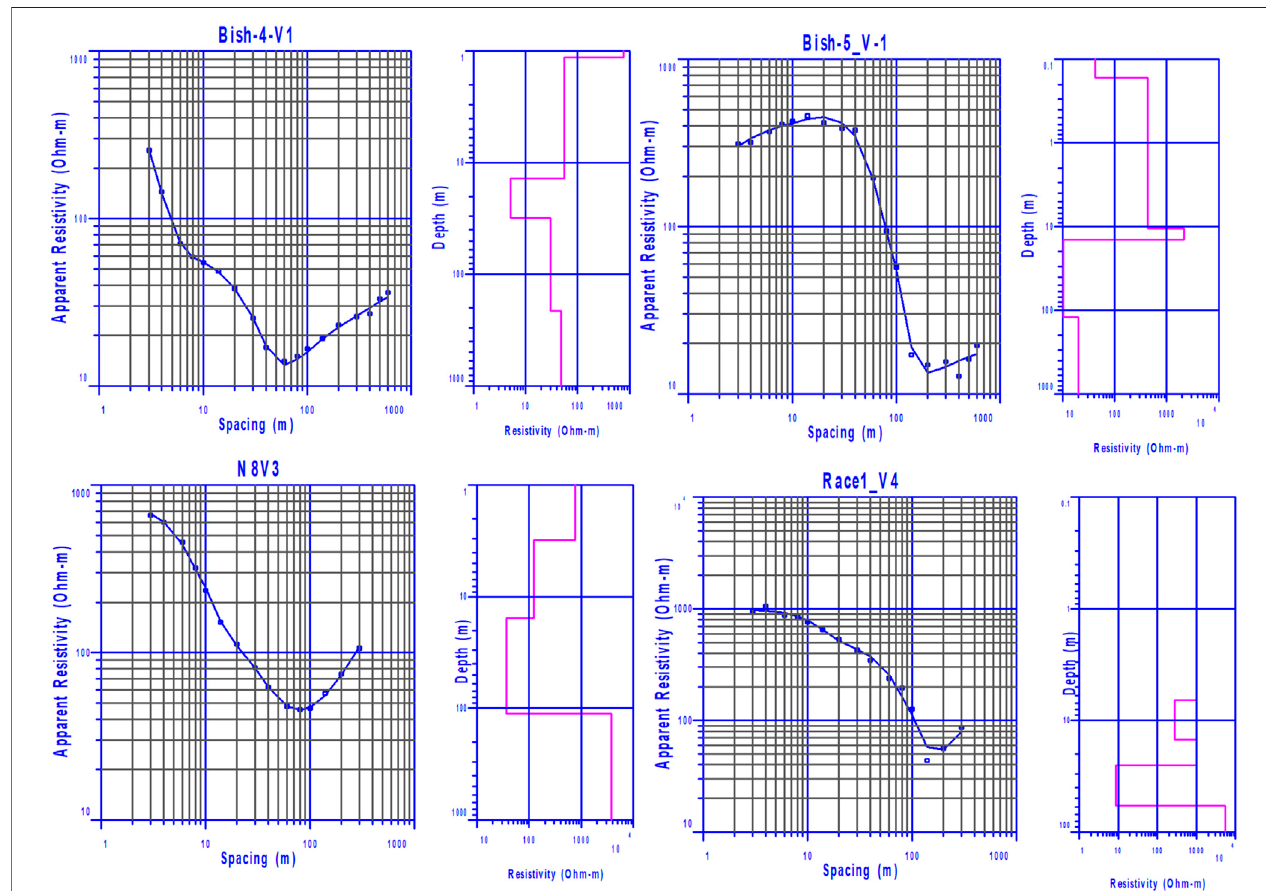
FIGURE 12 | The VES inverted